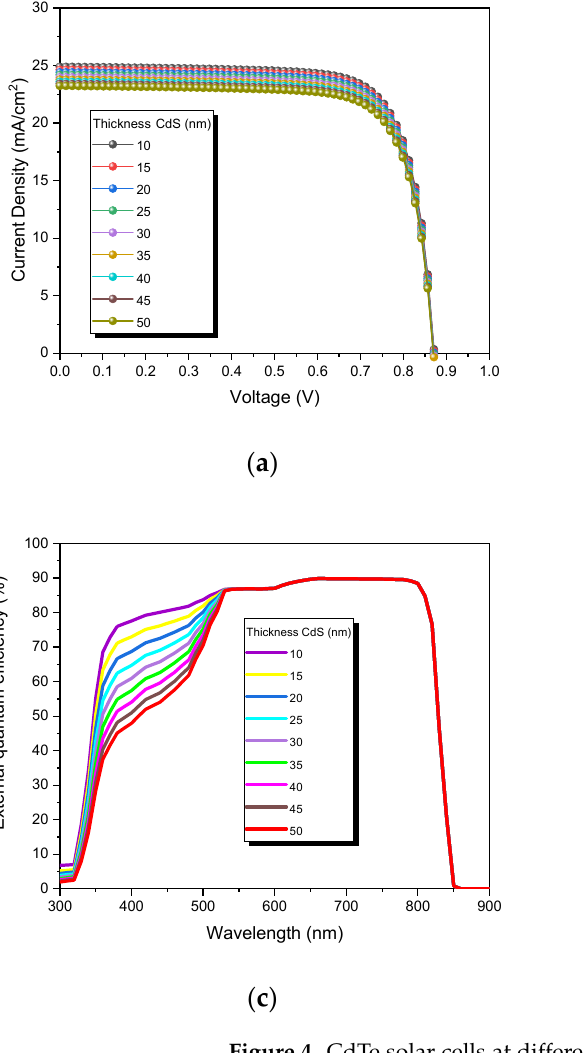
Table 4. Effect of the CdS thickness on the output parameters.